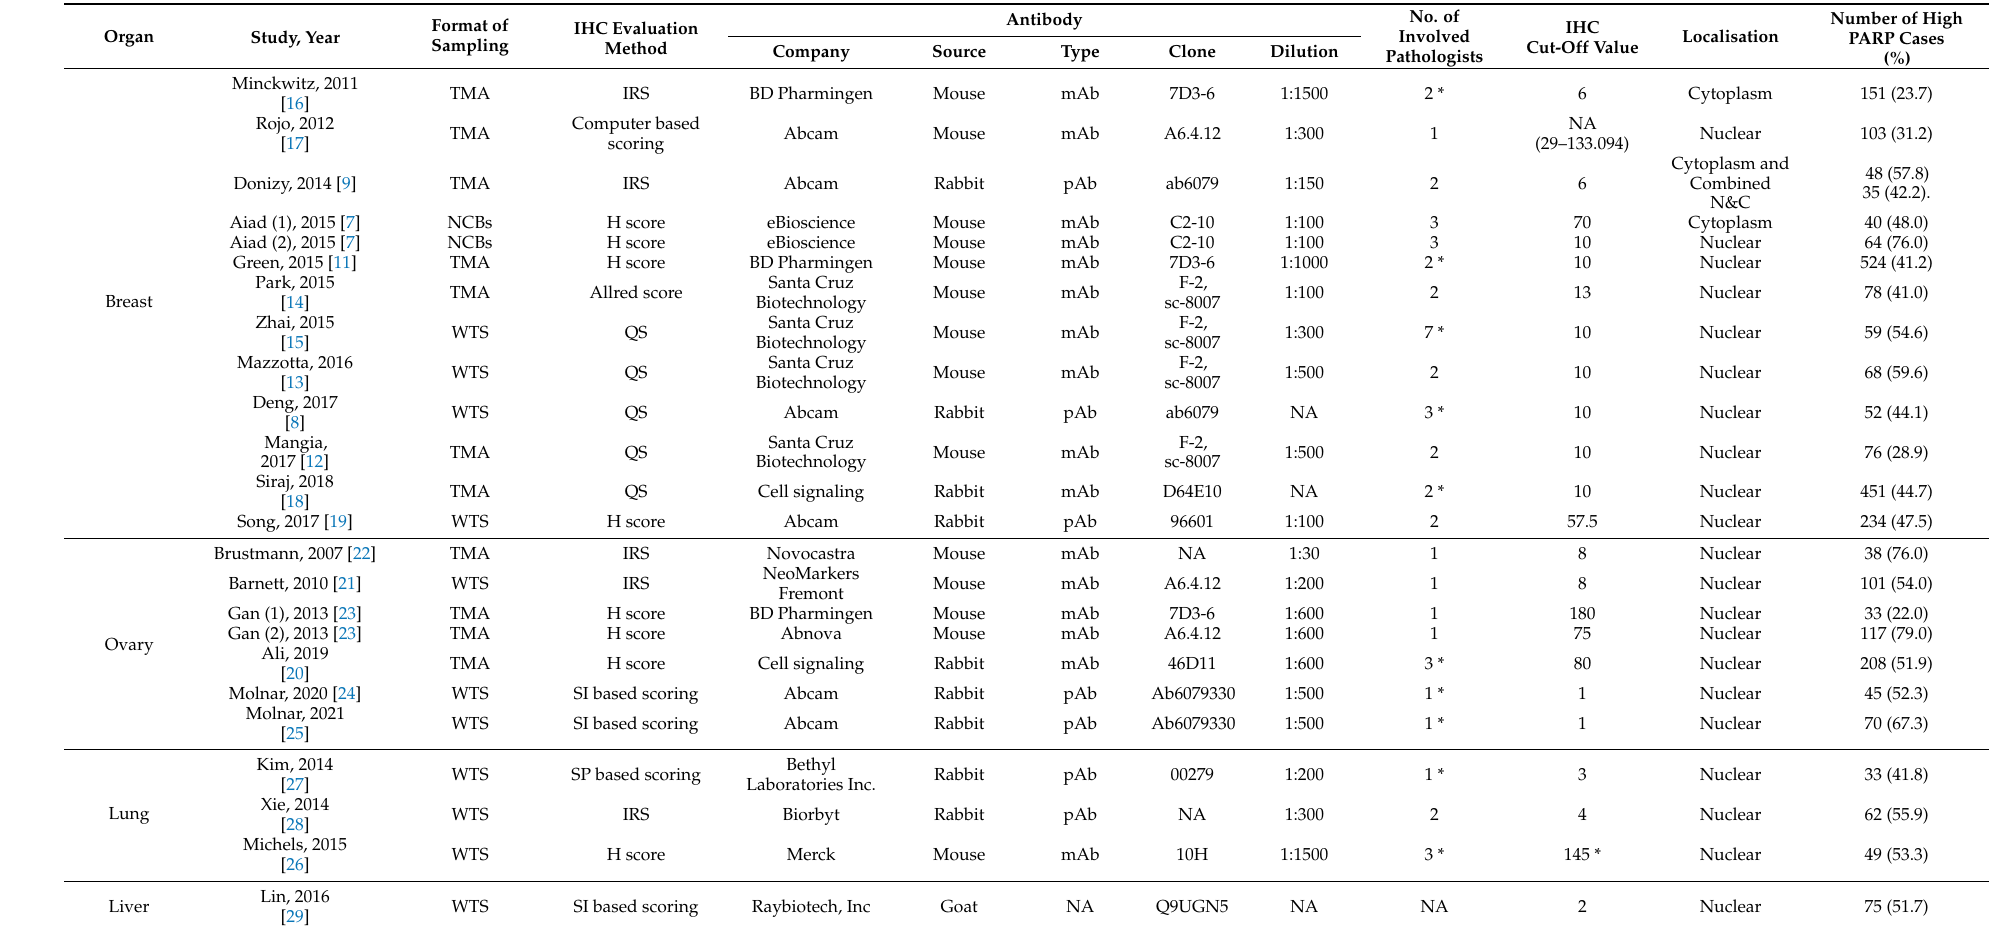
Table 2. Immunohistochemistry detection methods used for the PARP expression in the included